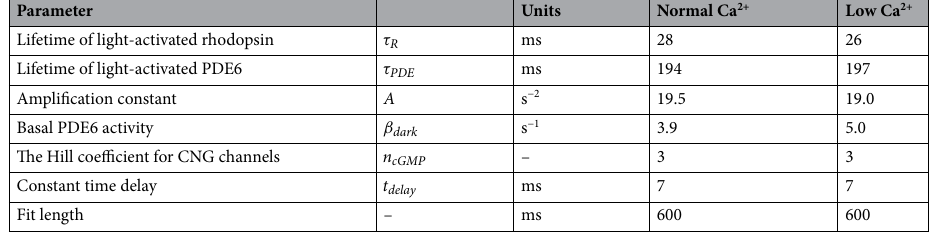
Table 2. The parameters used for fitting the phototransduction model in Fig. 6. The model was fitted to the responses from the moment of the flash stimulus to 600 ms after the stimulus. The cGMP level in darkness was calculated by dividing the synthesis rate of cGMP with the basal PDE6 activity. The mean τ D values from Pepperberg plots in normal and low Ca 2+ was used as the lifetime of light-activated PDE6. The amplification constant and the basal PDE6 activity could vary freely. The lifetime of light-activated rhodopsin was fixed to the values determined earlier.